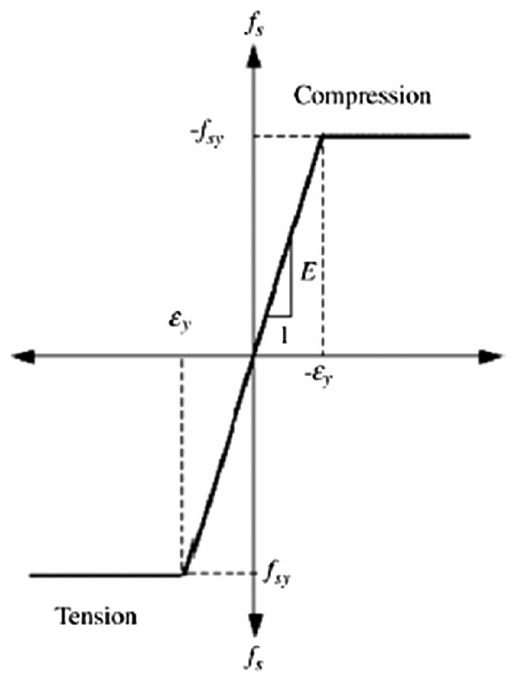
Fig. 2. Stress (cid:1) strain curve for steel